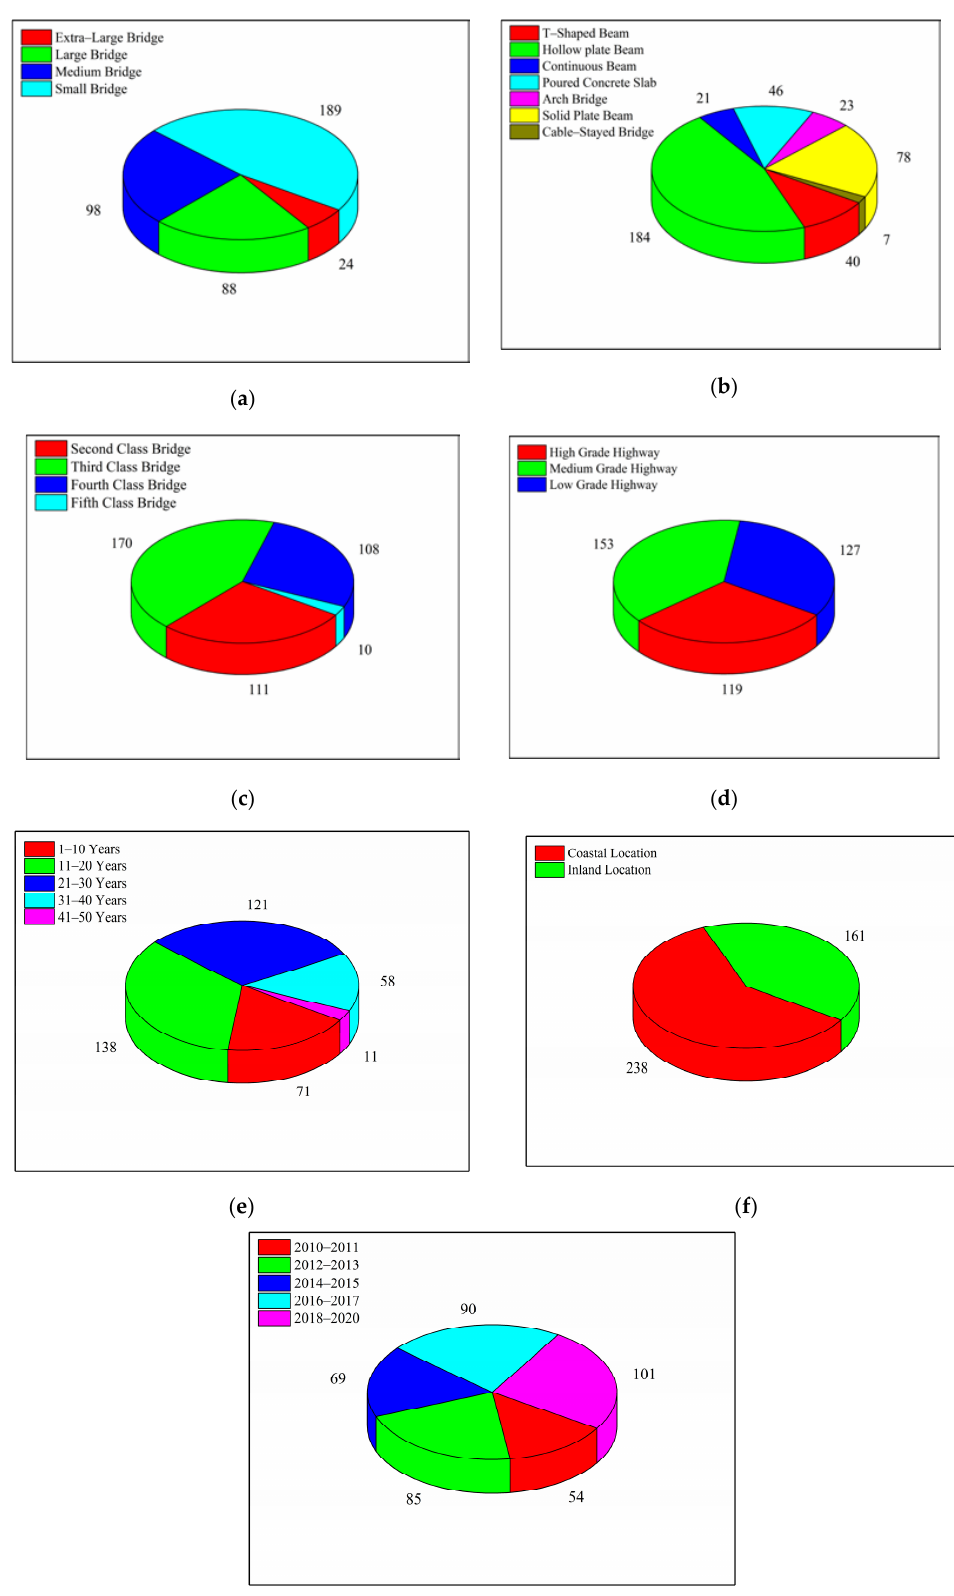
Figure 1. The classification of bridge maintenance cost samples; ( a ) bridge grade; ( b ) superstructure; ( c ) bridge technical condition; ( d ) highway grade; ( e ) bridge age; ( f ) bridge location; ( g ) maintenance time.